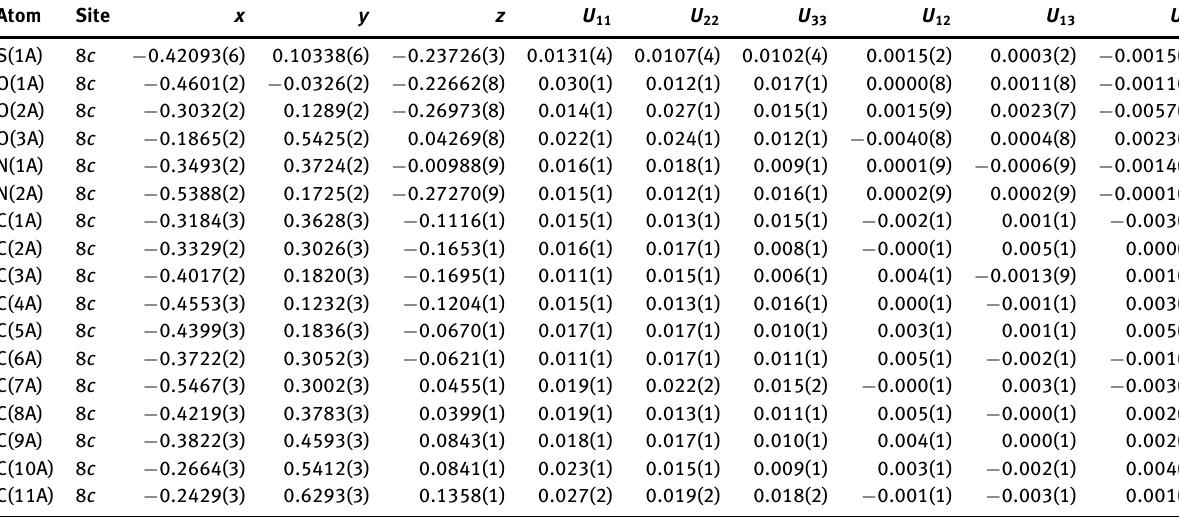
Table 3: Fractional coordinates and atomic displacement parameters (Å 2